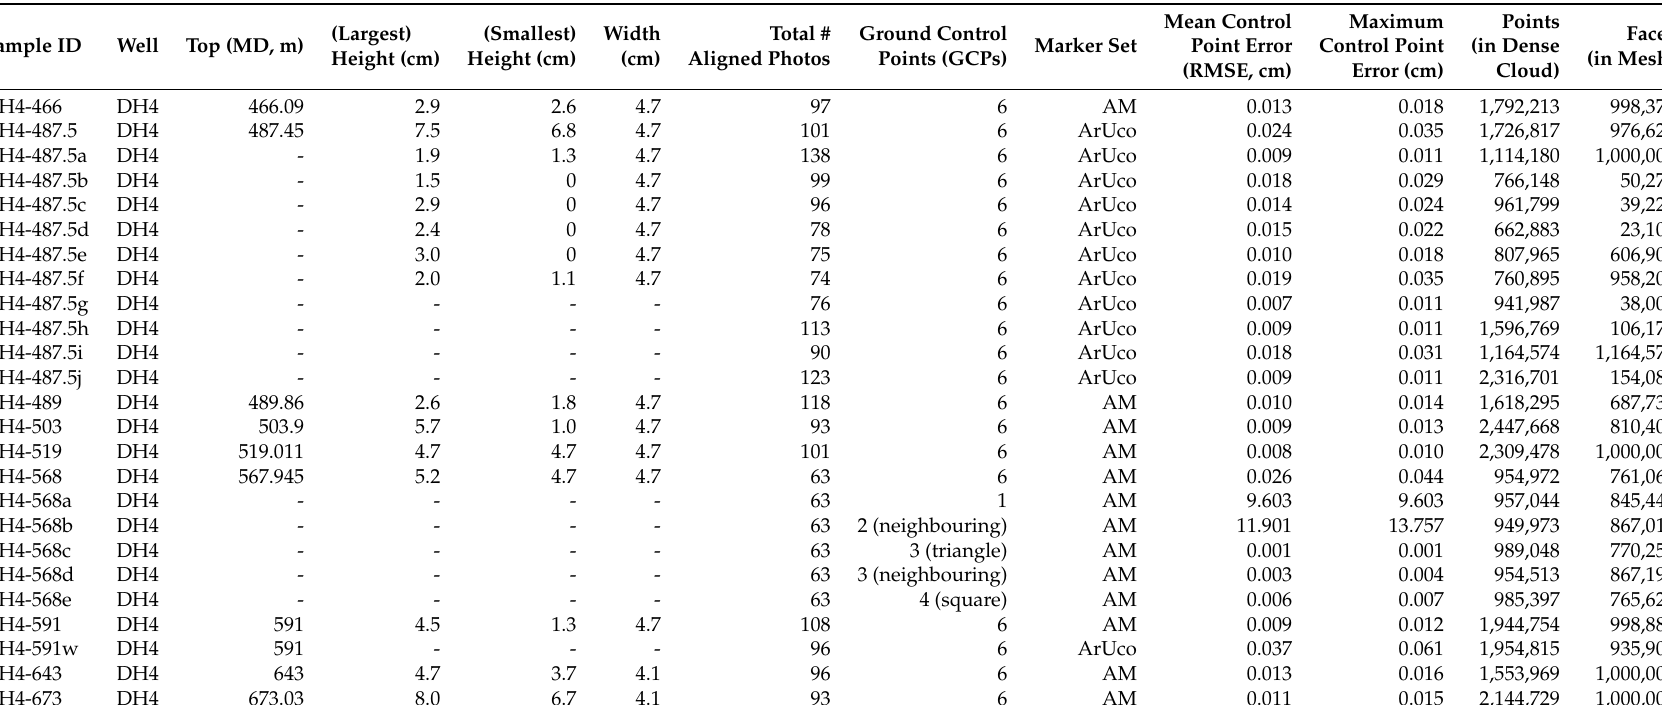
Table 1. Overview of sample origins, dimensions, and SfM parameters, results and errors. Refer to the main text for processing settings. AM: Agisoft Metashape marker; ArUco: ArUco